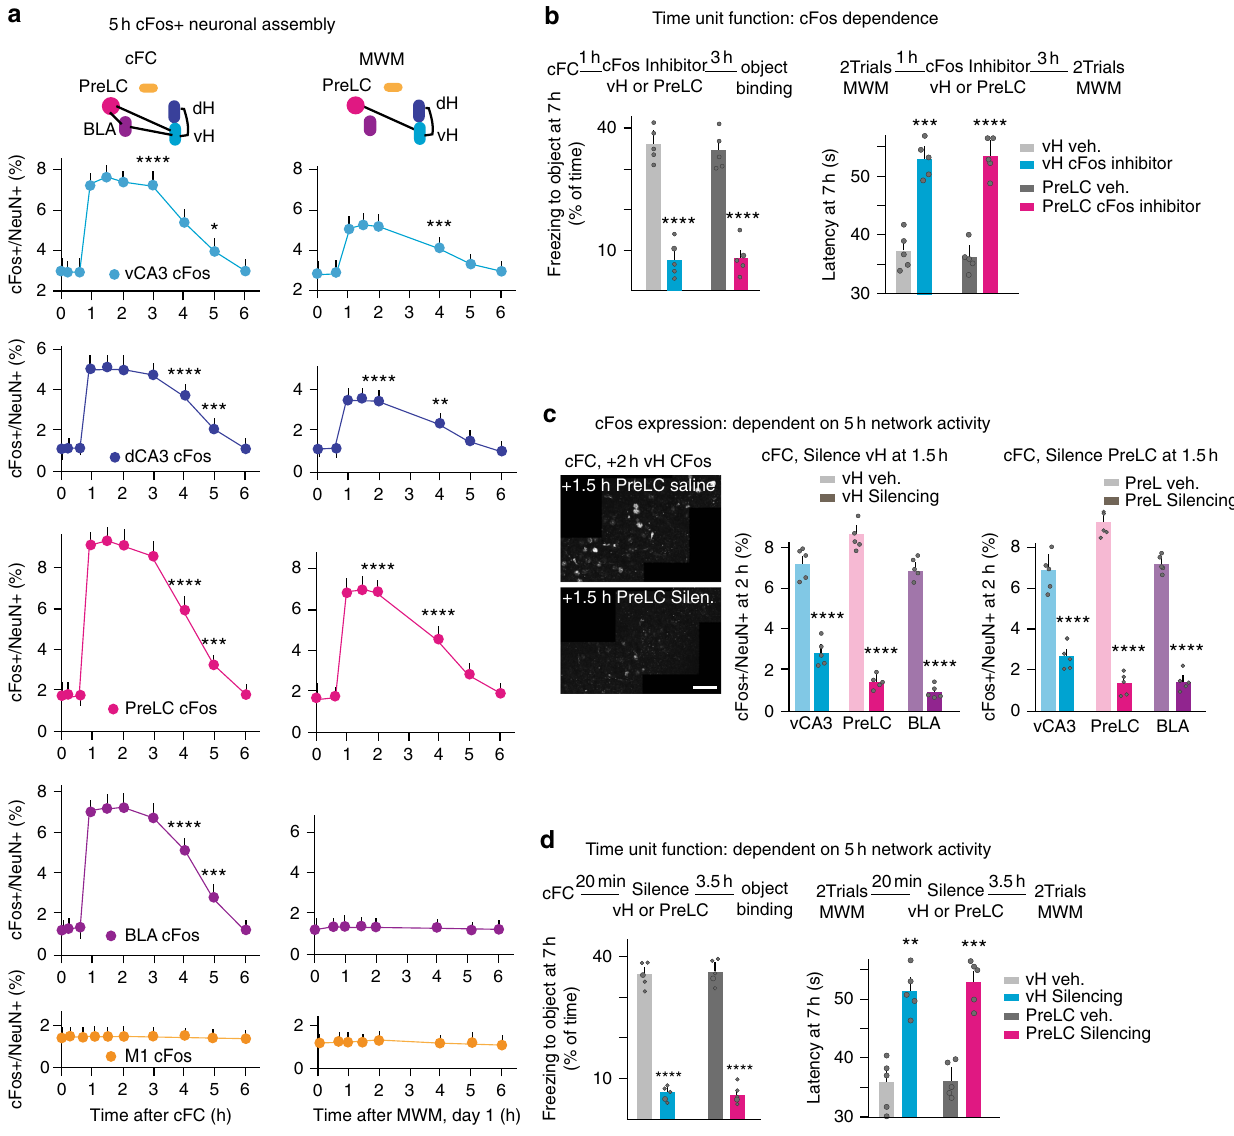
Fig. 3 Time unit for learning dependent on 5 h network activity and cFos function. a Time course of cFos induction in systems involved in cFC or MWM learning (four trials). Schematics: systems analyzed involved in cFC or MWM (connected by lines). cFC [One-way ANOVA; vCA3: P < 0.0001, dCA3: P < 0.0001, PreLC; P < 0.0001, BLA: P < 0.0001, M1: P = 0.5472], n = 5; MWM [One-way ANOVA, vCA3: P < 0.0001, dCA3: P < 0.0001, PreLC: P < 0.0001, BLA: P = 0.7868, M1: P = 0.9978]. n = 5. b Inhibiting cFos activity 1 h after acquisition locally in vH or PreLC prevents further time unit function in cFC and MWM learning. cFos inh.: local delivery of cFos inhibitor; veh.: vehicle (cFC: two-way ANOVA, Treatment, P < 0.0001, n = 5, 5, 5, 5; MWM: two-way ANOVA, Treatment, P < 0.0001, n = 5, 5, 5, 5). c , d 5 h network activity at systems used in learning required for system-wide cFos expression